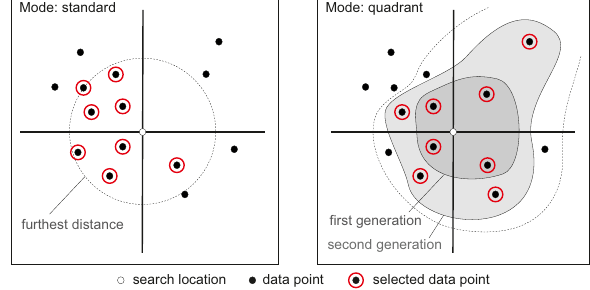
Figure 3. Different selection modes for querying eight nearest